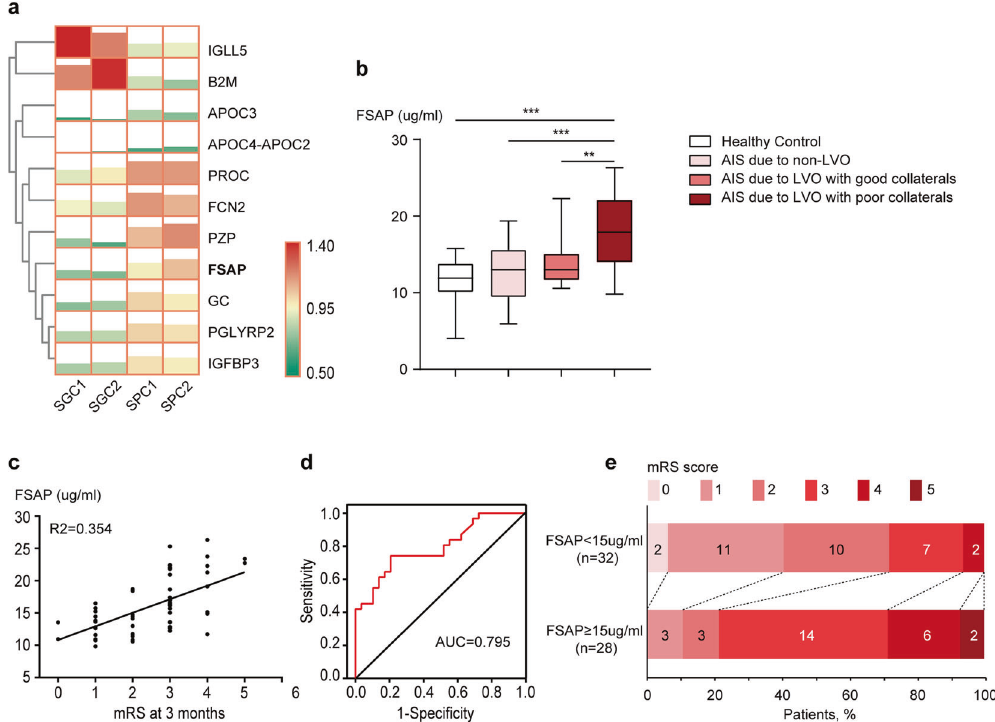
Fig. 1 Plasma FSAP levels increased in patients with ischemic stroke and were correlated with 3-month outcome. a Heatmap representation of hierarchical clustering of differentially expressed proteins based on proteomic analysis. The scale from 0.5 green (low abundance) to 1.4 red (high abundance) represents normalized abundance in arbitrary units. b Validation of FSAP expression by ELISA analysis. Data is expressed as median ± interquartile ranges; n = 30 for each group. ** p < 0.01, *** p < 0.001, horizontal lines and corresponding asterisks compare samples aligned with each end of the horizontal line by Kruskal – Wallis H -test. c – e Association of plasma FSAP levels with mRS 3 months post ischemia. Linear regression analysis of plasma FSAP levels with mRS 3 months post ischemia ( c ), receiver operating characteristic curve of plasma FSAP levels in prognosis of poor outcome (mRS 3 – 6) ( d ), and the distribution of the mRS scores at 3 months by FSAP levels ( e